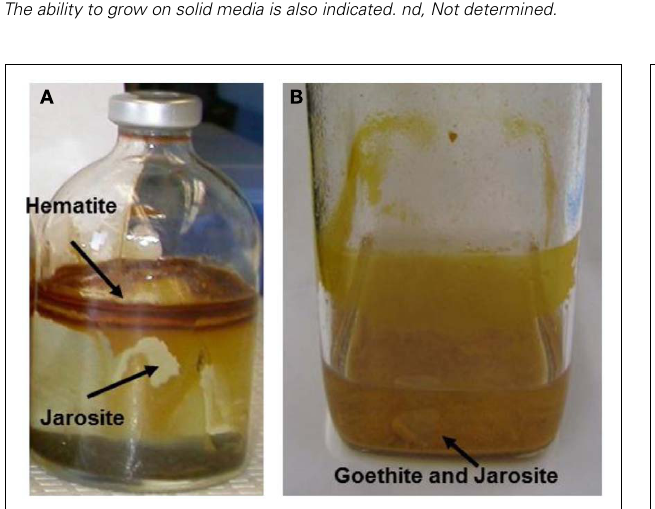
cluster in S. tokodaii (Bathe and Norris,2007). Like S. tokodaii and